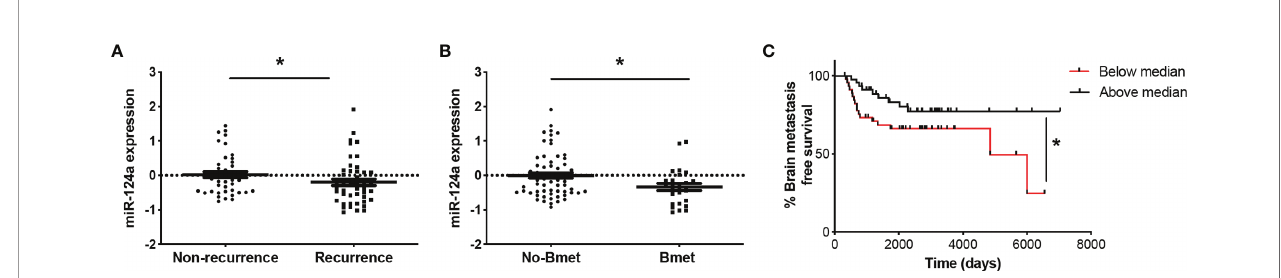
FIGURE 6 | Low miR-124a levels in primary melanoma correlate with recurrence, brain metastasis recurrence, and decreased brain metastasis-free survival. Primary human melanoma samples were collected at the time of surgery from 92 patients enrolled in the NYU Melanoma Program (IMCG) database. miRNA expression pro fi ling of FFPE-extracted RNAs from primary melanomas was performed by Exiqon, Inc., using miRCURY ™ LNA arrays (Exiqon, Denmark) (20). (A) Relative miRNA-124 expression was compared between primary tumors based on their recurrence status (Mann – Whitney test; *p = 0.047). (B) Relative miRNA-124 expression in primary tumors that eventually metastasized to the brain (Bmet) vs. primary tumors that did not metastasize or metastasized to other organs (No-Bmet) (Mann – Whitney test; *p = 0.02). (C) Brain metastasis-free survival analysis shows that low miR-124a correlates with increased brain metastasis incidence (Breslow – Wilcoxon test; *p = 0.05). Low and high miR-124a levels are relative to the